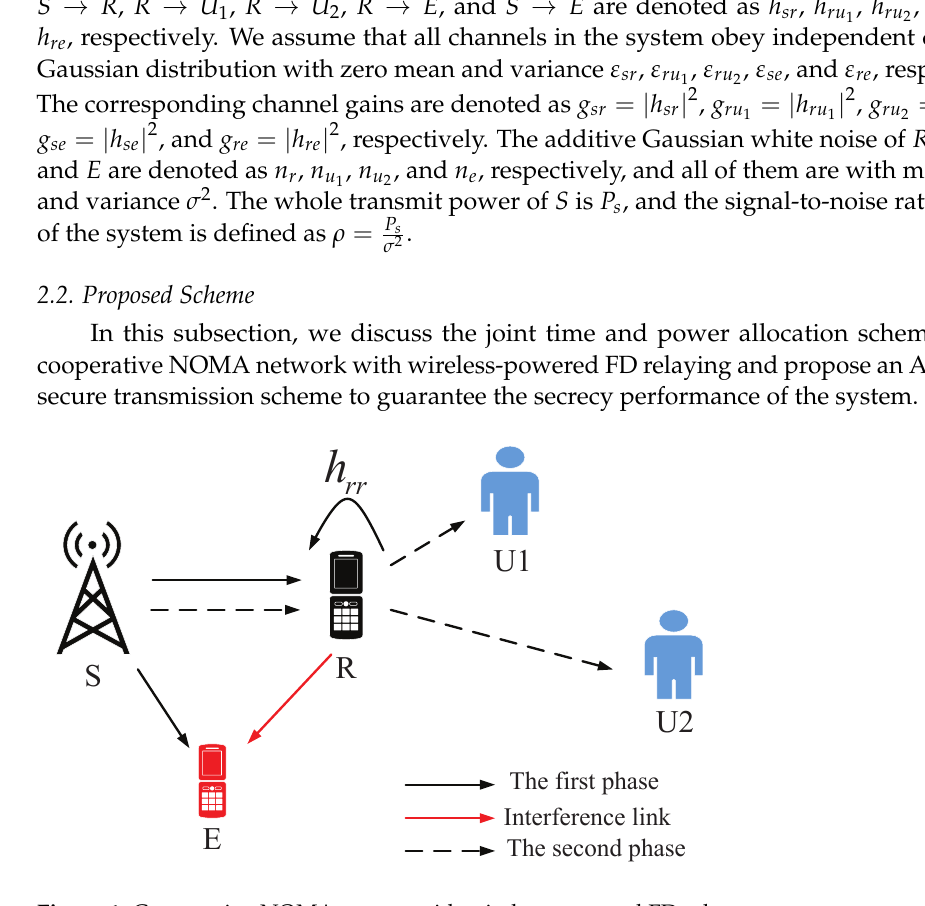
Figure 1. Cooperative NOMA system with wireless-powered FD